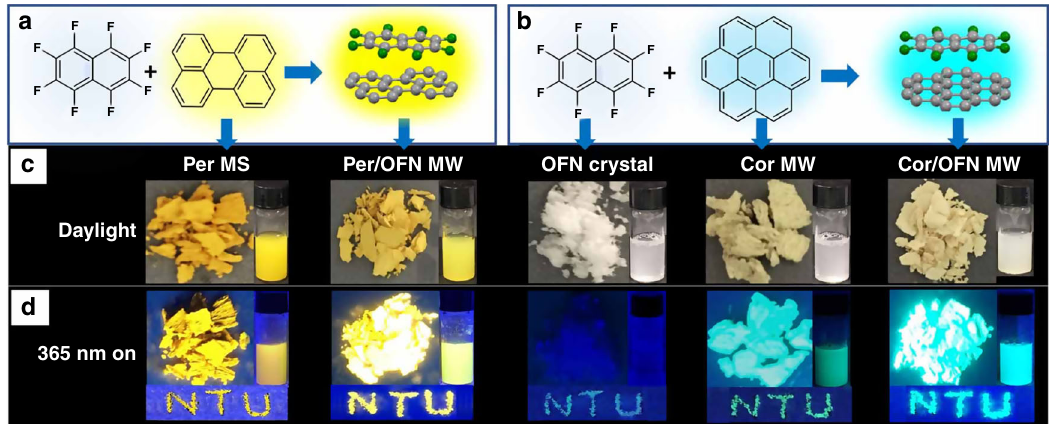
Fig. 4 cocrystallization schemes of Per/OFN MW ( a ) and Cor/OFN MW ( b ) and corresponding photos. The corresponding photographs of the fi ve